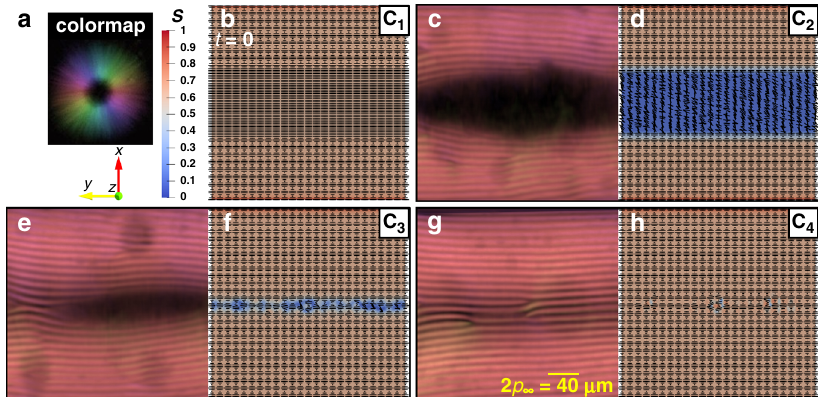
Fig. 3 Mechanism of smooth dynamic in CNC relaxation. a The colormap indicating the fi ber orientation in the experimental POM panels captured by the LC PolScope device (see Supplementary Note 1 for further information), the blue-to-red spectrum showing the order parameter, S , computed by direct numerical simulation (see Supplementary Note 6 for further information), and the coordinate system. b Initialization of director fi eld in direct numerical simulation, representing the initial con fi guration of fi bers. c , e , g The experimental POM panels corresponding to the C 2 to C 4 stages shown in Fig. 1n. d , f , h The schematic fi bers orientation and their order parameter computed by direct numerical simulation in the lateral plane for the C 2 to C 4 stages shown in Fig. 1n. General Note: the label numbers from C 1 through C 4 are marked in Fig. 1n.